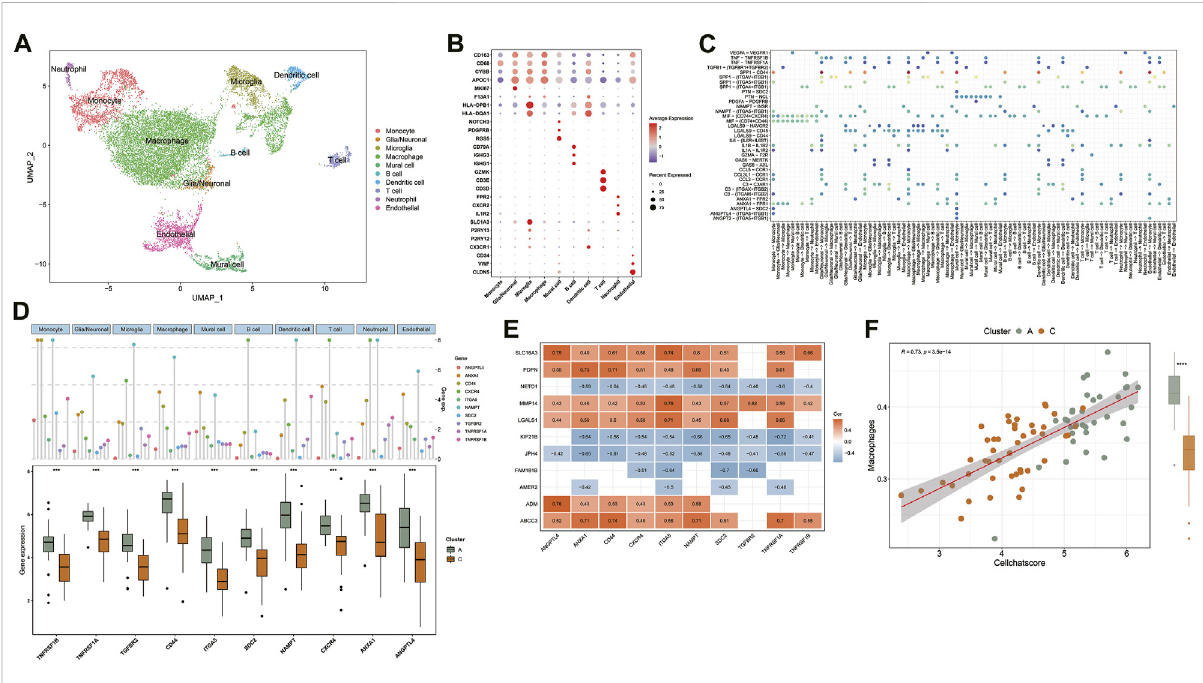
FIGURE 3 (A) UMAP ofSingle-cellsequencingdata,coloredforthe10cell clusters. (B) Dot plotheatmapofthemarkergenesinindividual cellclusters. (C) The dot plot shows the signi fi cant signaling patterns and ligand-receptor pairs. Dot color re fl ects communication probabilities and dot size represents computed p -values. The highlighted signals are pathways in which ligand-receptor genes are differentially expressed between clusters. (D) Expression distribution of differentially expressed ligand-receptor genes in 10 cell clusters and comparison of expression between TCGA sample clusters A and C. (E) Heatmap shows Spearman ’ s correlations between PCGI methylation-driven genes and ligand-receptor genes. (F) The correlation between Cellchat score and macrophage in fi ltration